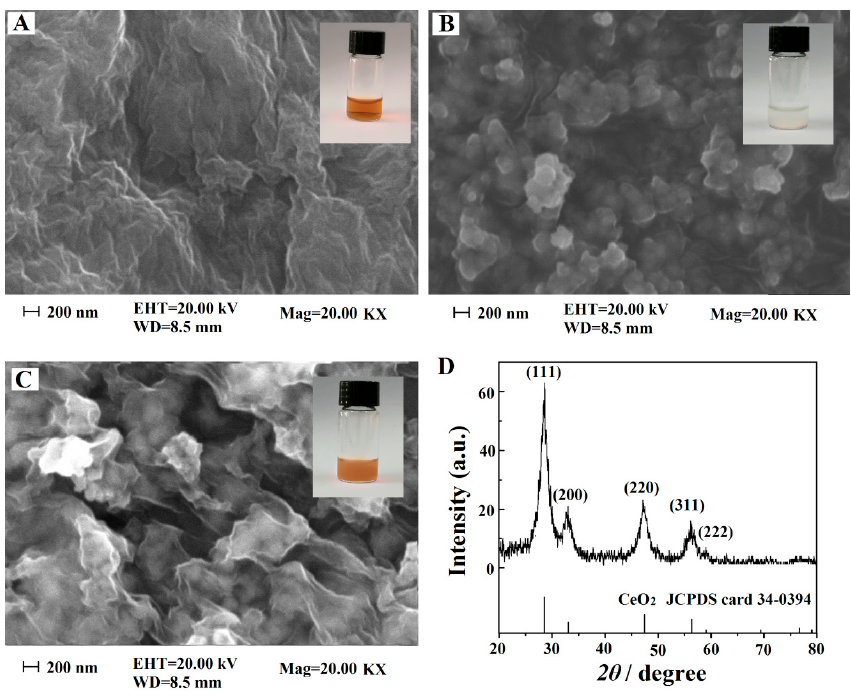
Figure 1. SEM images of ( A ) GO, ( B ) CeO 2 , ( C ) CeO 2 / ERGO nanocomposite and( D ) the XRD pattern of CeO 2 . Inset: digital camera images of the pure GO, CeO 2 and CeO 2 /ERGO nanocomposite. Nanomaterials 2020 , 10 , x